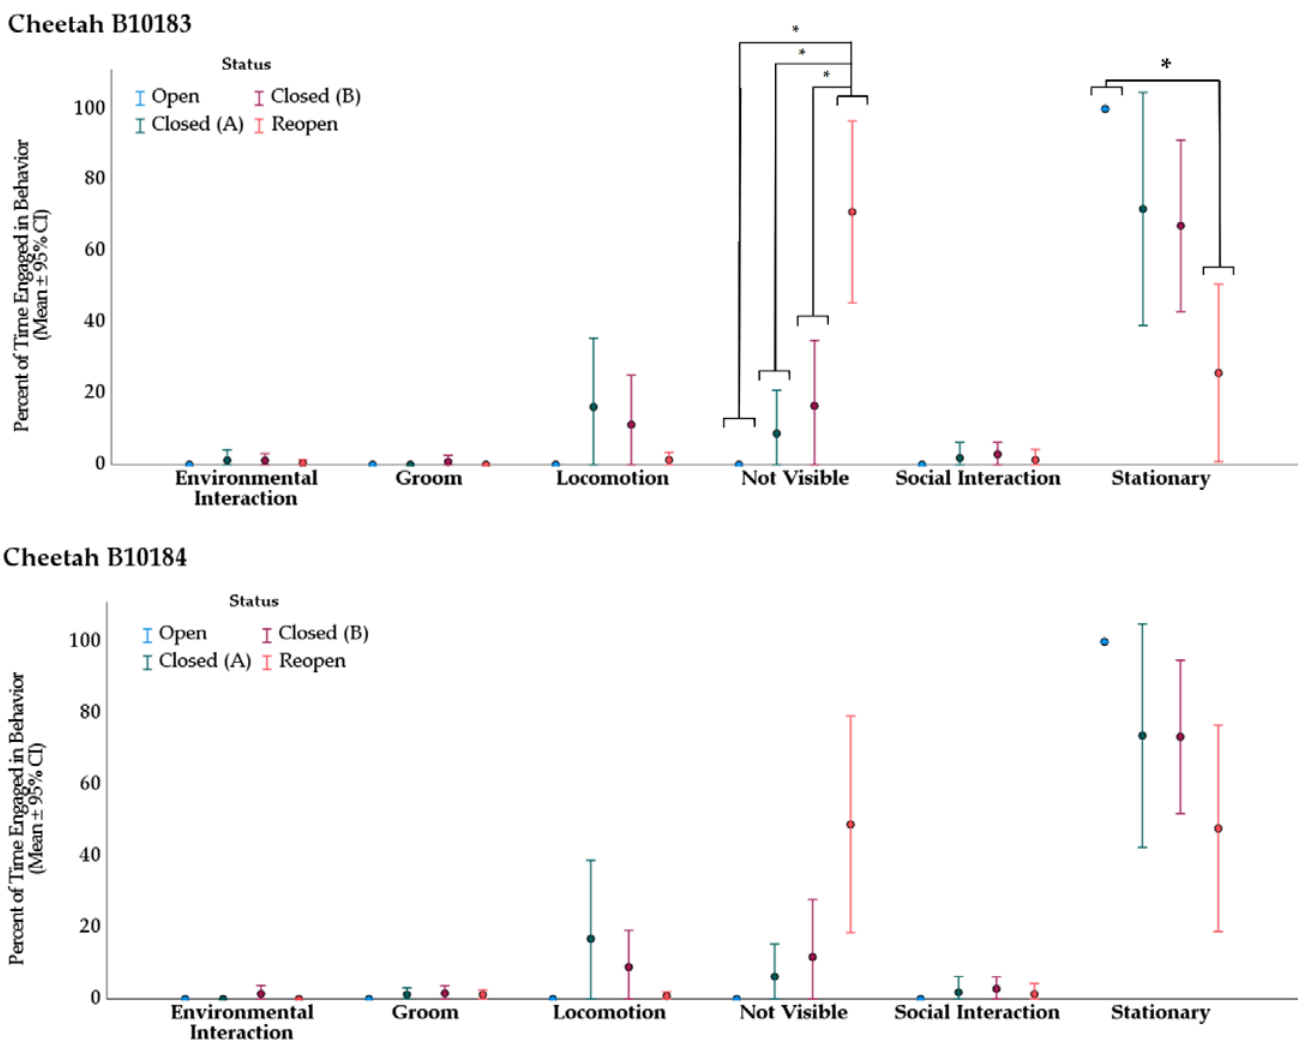
Figure 3. Cheetah average behavior expression proportion (%). Proportion indicates percent of total observation time con- ducting the behavior. Error bars are 95% confidence intervals. Asterisks (*): significance at α = 0.95. Observations in category “Open” were 60-minutes and conducted by volunteers. All others were 20-minutes and conducted by the first author. Table 6. Significant (α = 0.95) results of the behavior engagement analysis for cheetah based on the Zoo’s opening status. Pairwise comparisons (Dunn 1984) were conducted on significant results from Kruskal–Wallis (H) tests. Asterisks ( * ) indicate adjusted p -values (Bonferroni correction for multiple comparisons).